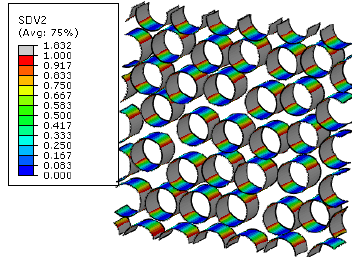
Figure 33. Damage propagation in the interface of fiber random distribution model.